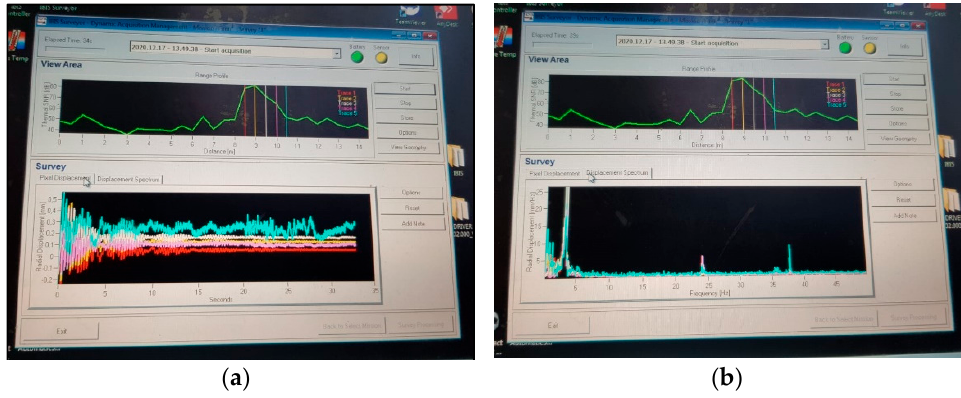
Figure 11. ( a ) Screenshot showing the bins corresponding to the highest peaks of the received signal identified and selected to show the displacement time series in real-time from the control PC; ( b ) Screenshot of the control PC returning the frequency analysis for the selected bins with highest peaks in real-time.